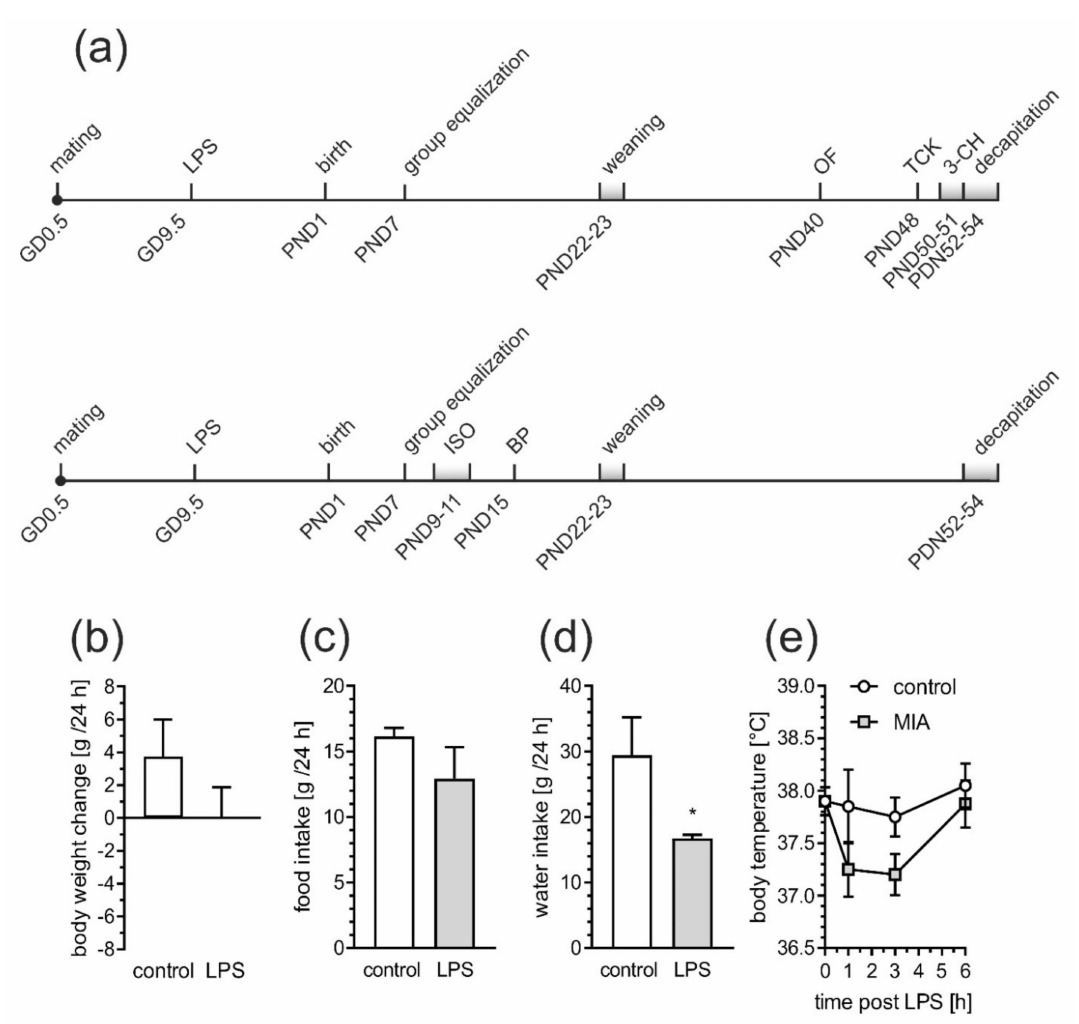
Figure 1. Lipopolysaccharide induces sickness behavior in pregnant female rats. LPS (100 µ g / kg body weight) was injected intraperitoneally to pregnant rats at gestation day 9.5. The body weight, food intake, water intake and body temperature were recorded. ( a ) Study design. GD—gestation day, PND—postanal day ISO—maternal isolation test, BD—bedding preference test, OF—open field test, TCK—tickling test, 3-CH—three chamber social test. ( b ) The change in body weight during 24 h post-injection (n = 4). ( c ) Food intake during 24 h post-injection (n = 4). ( d ) Water intake during 24 h post-injection (n = 4). ( e ) The change in rectal body temperature during 6 h post-injection (n = 4). * p < 0.05, compared to control group using Student’s t